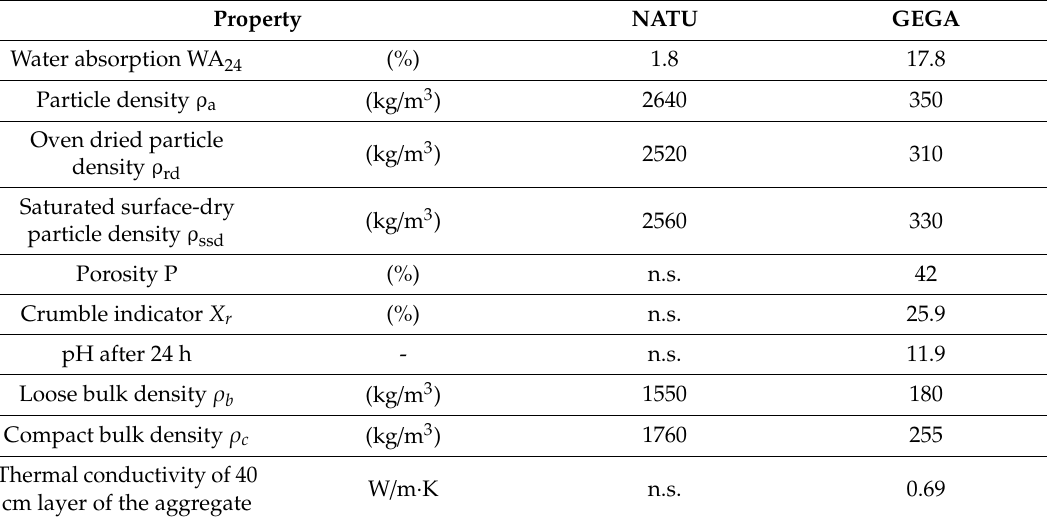
Figure 2. Distribution curves of aggregates size.